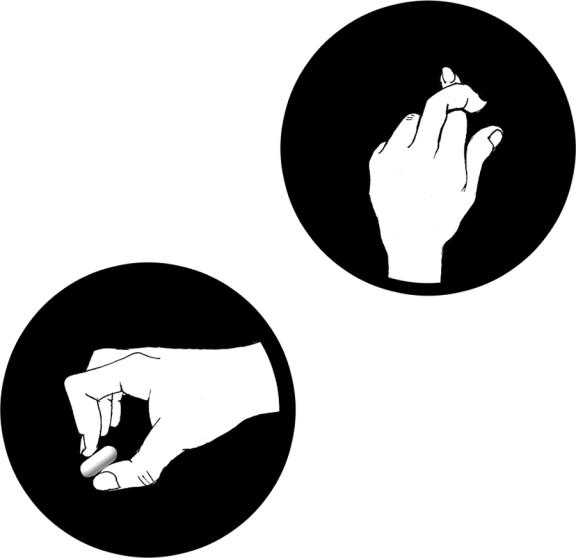
Deception of research participants is considered necessary to understanding the placebo effect—but has received little ethical attention(Illustration: Margaret Shear, Public Library of Science)